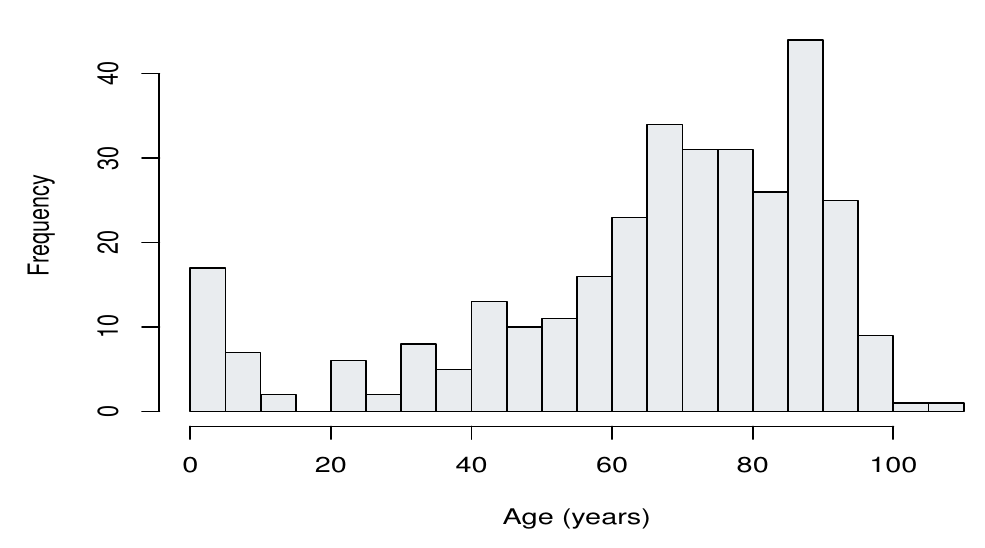
Figure 5. Histogram of the covariate “age”.